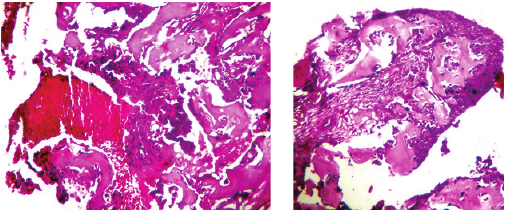
Figure 6: Microphotograph of HPE of resected specimen of left humerus showing metastatic squamous cell carcinoma (H&E stain,